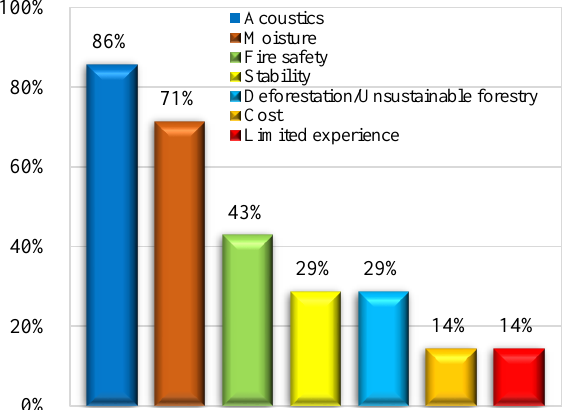
Figure 7. Disadvantages of constructing with wooden frames considered by UERs.